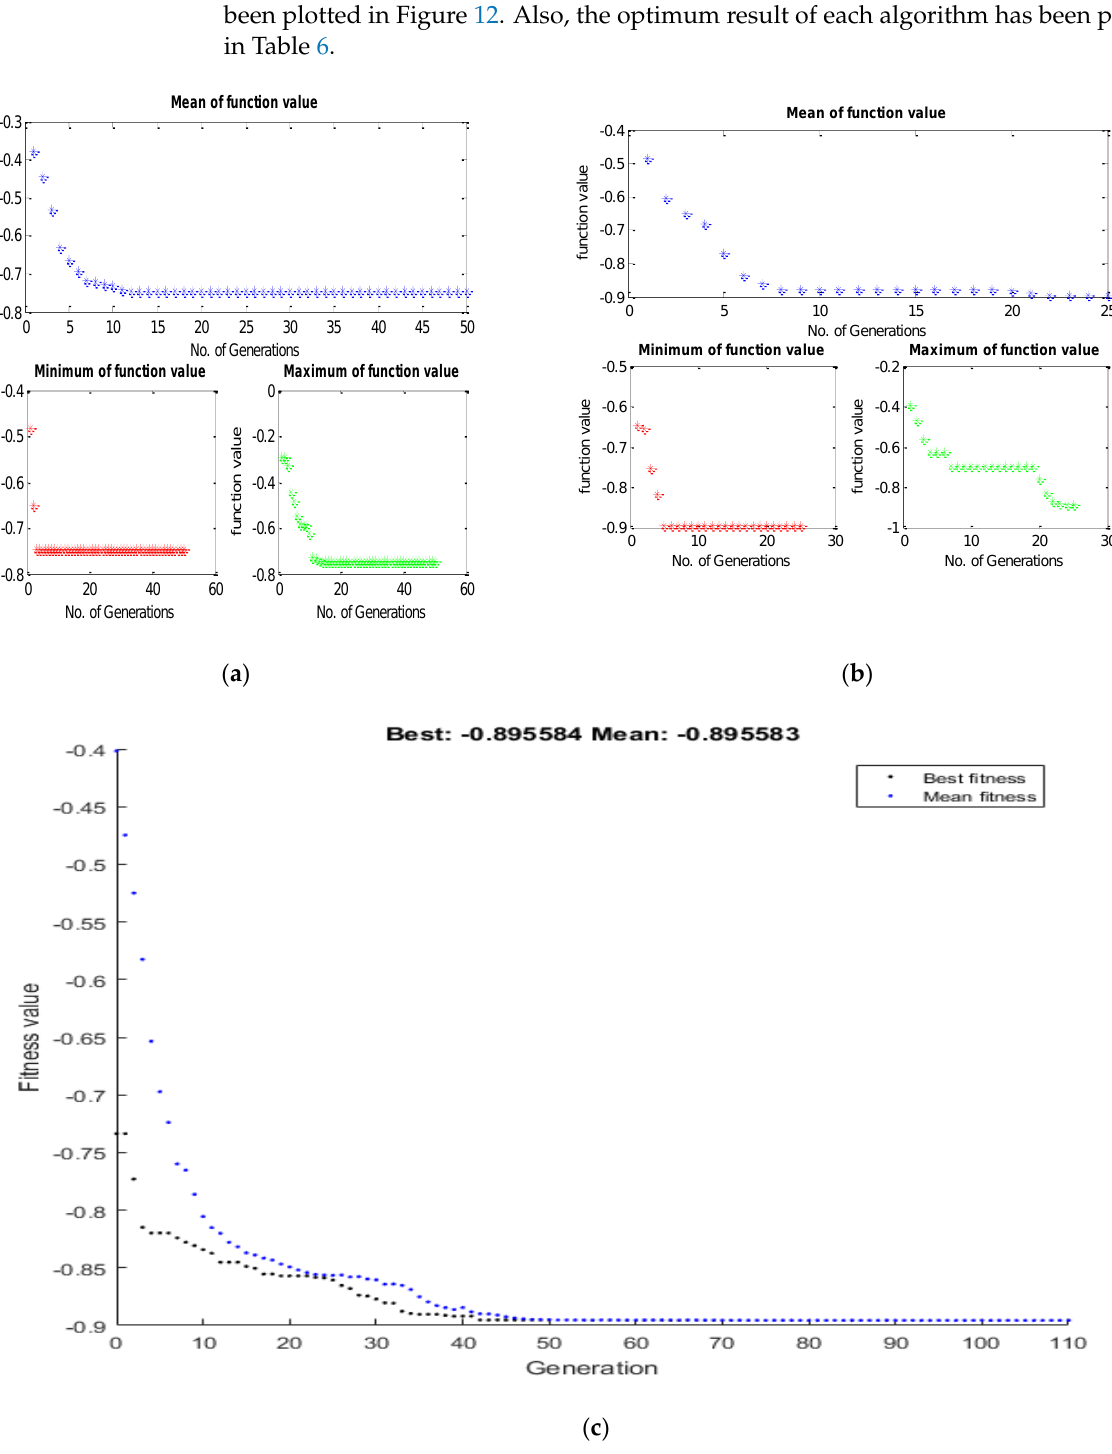
Figure 12. Comparative Convergence plot for the MPCI by TLBO JAYA and Genetic Algorithm. 0